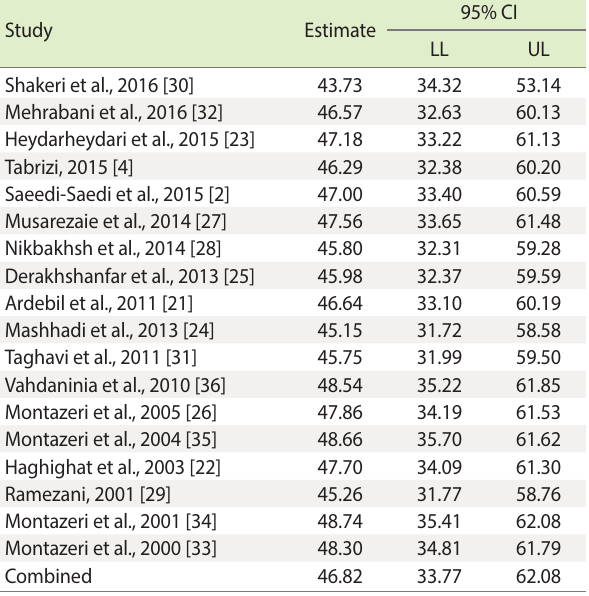
Table 3. Sensitivity analysis of studies included in the meta-analysis Study